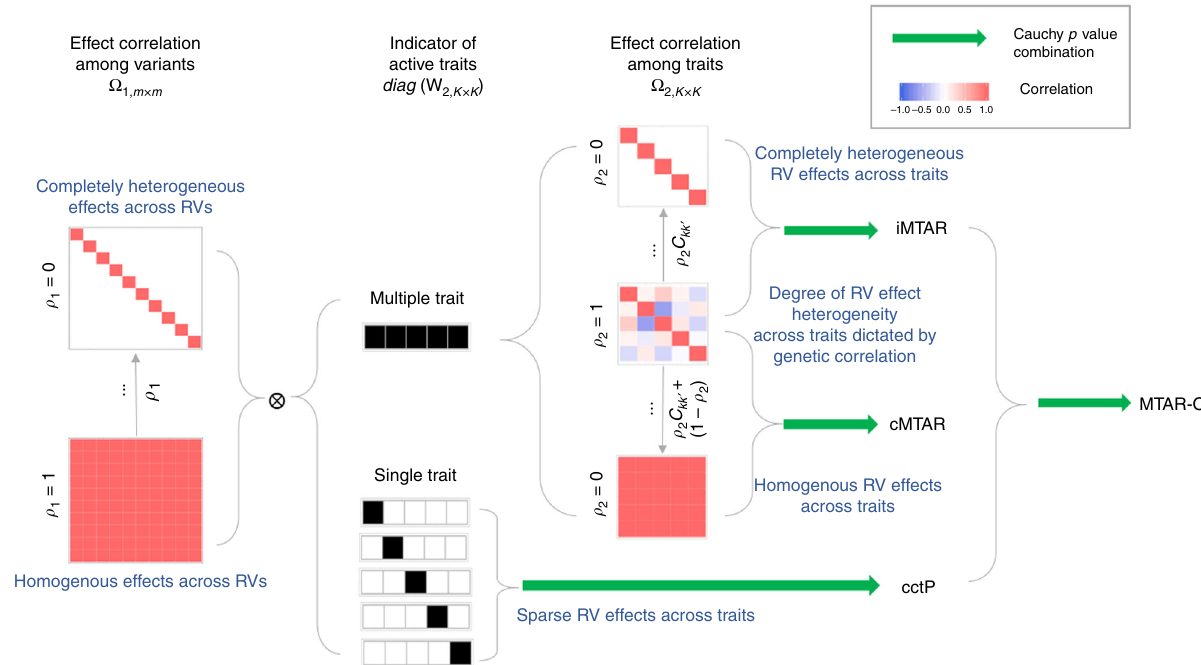
Fig. 1 Summary of methods under MTAR framework. In this illustration, the number of variants is m = 10 and the number of traits is K = 5. The degree of heterogeneity of among-variant effects is controlled by ρ 1 . MTAR methods are robust to various patterns of genetic effects across variants by combining variance-component test P -values from different speci fi cations of ρ 1 . The degree of heterogeneity of among-trait effects is controlled by ρ 2 . By changing the value of ρ 2 , the degree of heterogeneity of among-trait effects can be weakly, moderately, or strongly dictated by genetic correlation C kk ′ . By setting ρ 2 = 0, iMTAR and cMTAR structures assume genetic effects become completely heterogeneous and homogeneous, respectively. MTAR methods are robust to various patterns of genetic effects across traits by combining variance-component test P -values from different speci fi cations of ρ 2 . The cctP that combines the single-trait burden and SKAT tests P -values is particularly powerful when only a small number of traits are associated with the set of rare variants. The omnibus test MTAR-O that combines iMTAR, cMTAR, and cctP is robust to all the aforementioned patterns of genetic effects across traits and